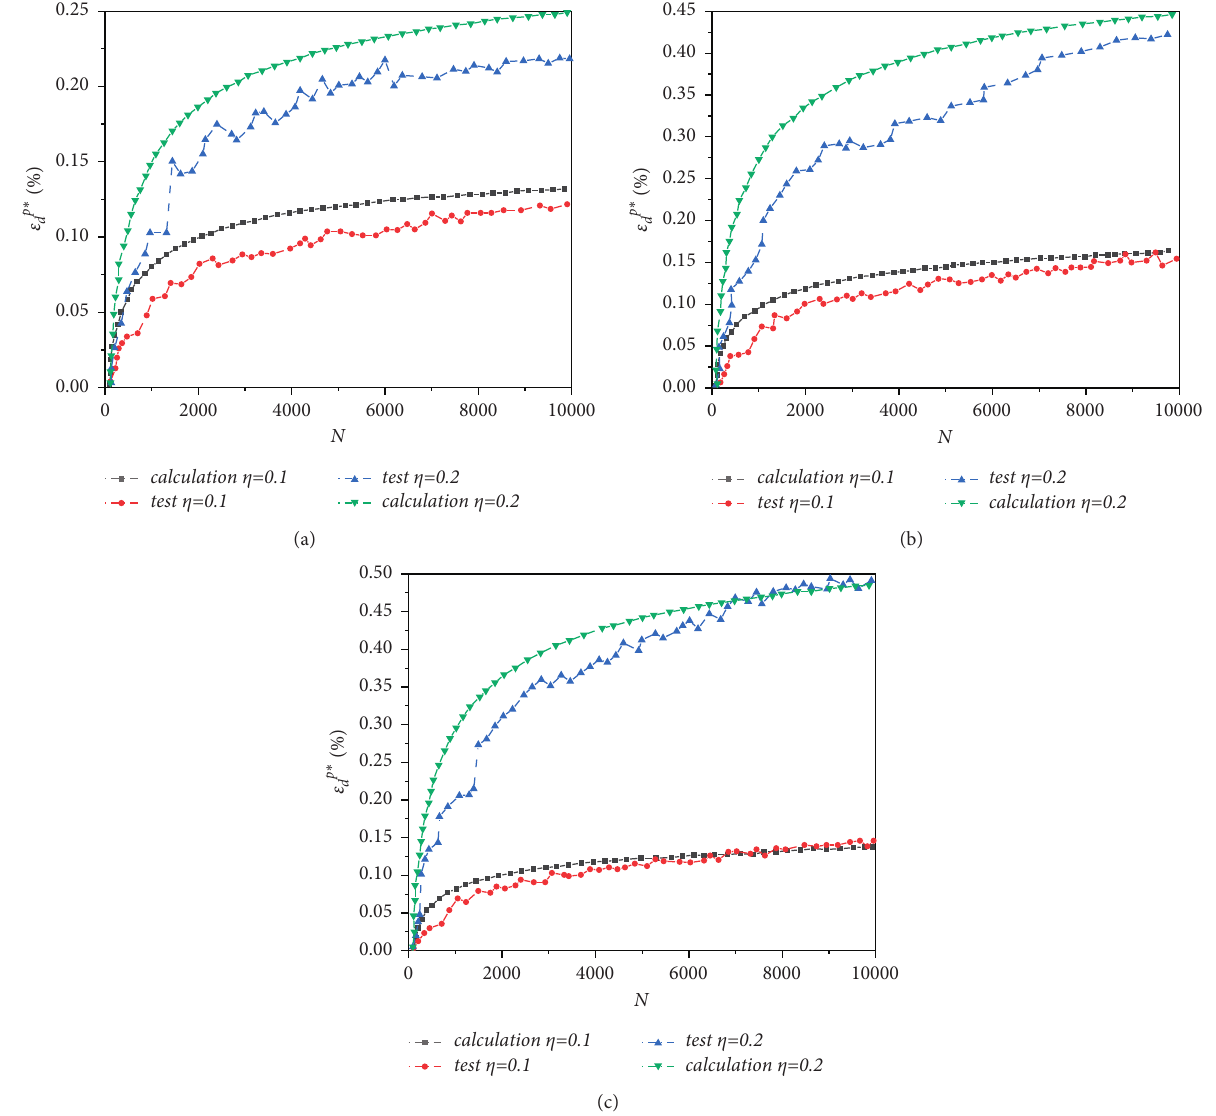
Figure 10: N − ε p ∗